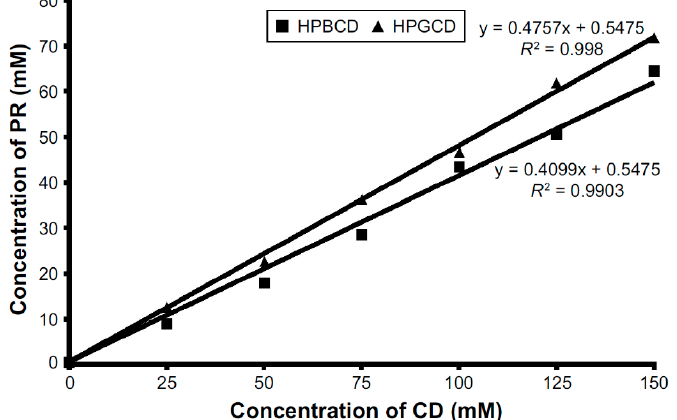
Figure 3. Phase–solubility diagram of prednisolone (PR)-hydroxypropyl- β -cyclodextrin (HPBCD) and PR-hydroxypropyl- γ -cyclodextrin (HPGCD) inclusion complexes. The solubility of PR increased linearly by increasing the concentration of cyclodextrins (CDs). The curve is A L type, thus inclusion complexes with 1:1 molecular ratio are formed in the case of HPGCD and HPBCD